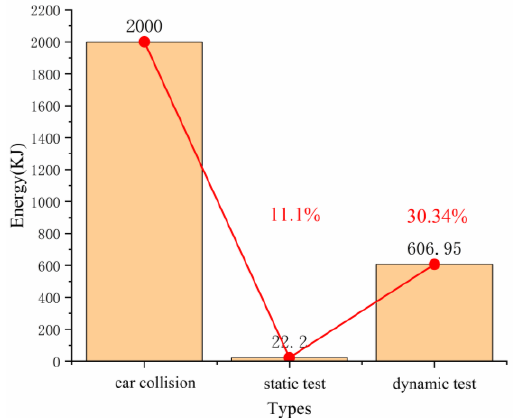
Figure 21. The energy comparison of collision.